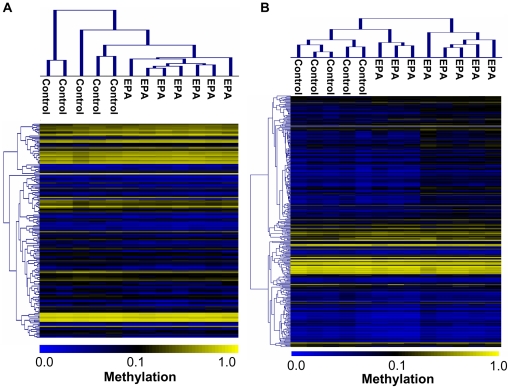
Unsupervised hierarchical clustering.Methylation percentages (β values) at all the significant loci from infant and adult PA monkeys and control monkeys (panel A: 163 loci for infant data; panel B: 325 loci for adult data). Top horizontal bars indicate sample clusters. Scale displays methylation percentage (yellow indicates 1; blue indicates 0).